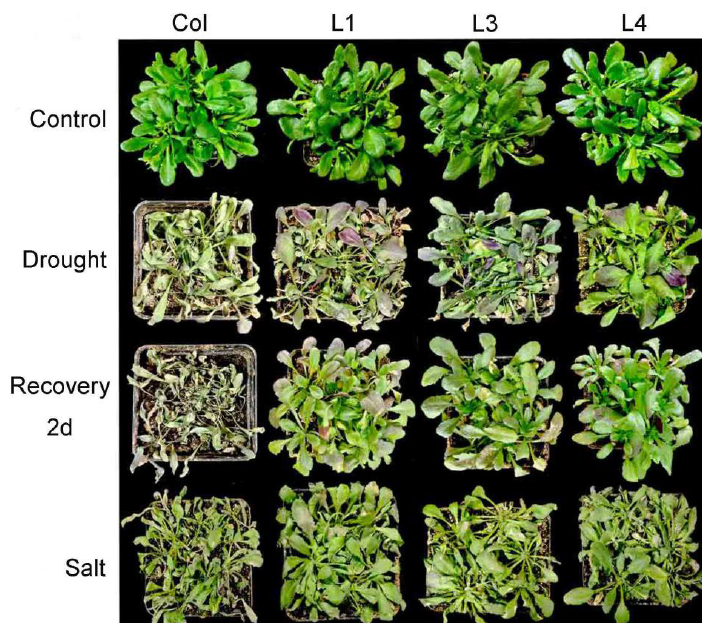
Fig. 4: Phenotypes of transgenic and wild-type A. thaliana lines under drought and salt